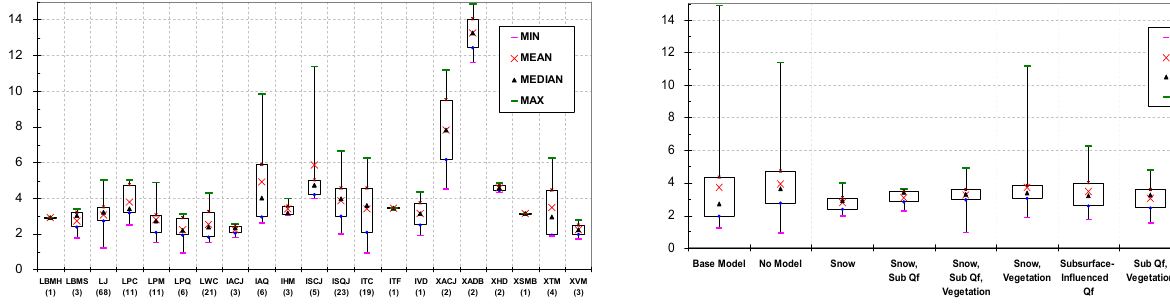
Fig. 8. Total streamflow FDC slopes grouped by catchment class. Fig. 9. Total streamflow FDC slopes grouped by dominant model